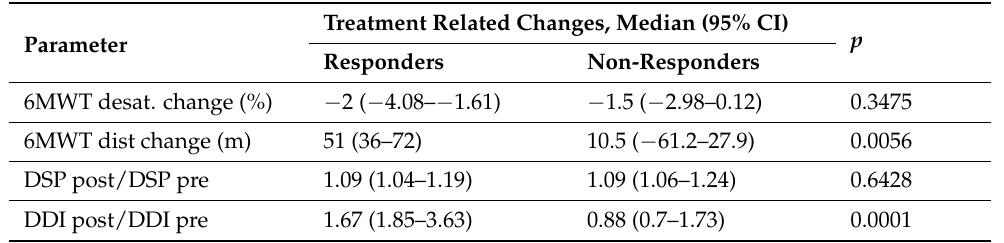
Table 6. Treatment-related change (medians with 95% CI) in 6MWT parameters according to the type of response to treatment (Mann-Whitney test).